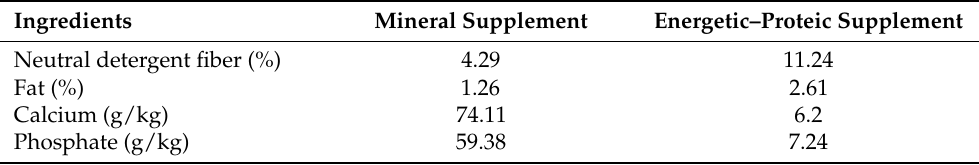
Table 2. Contents of ingredients and nutrients of supplement for cows. Ingredients